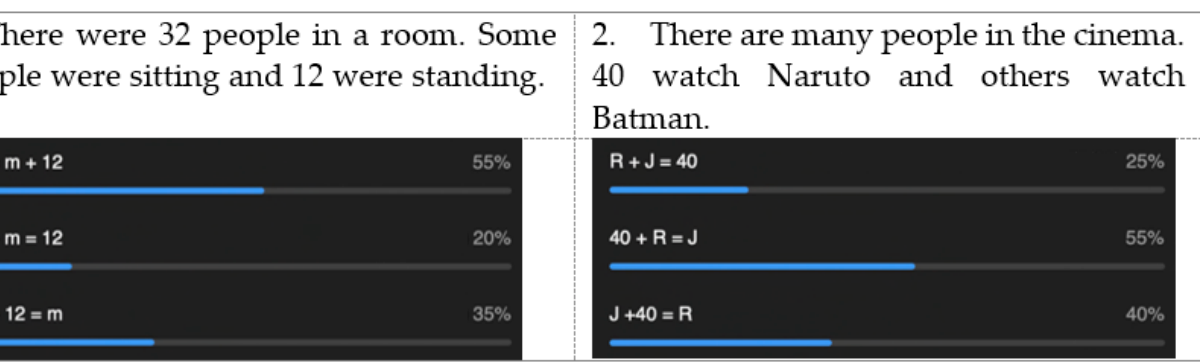
Figure 7. Test on translation from natural language to algebraic language.